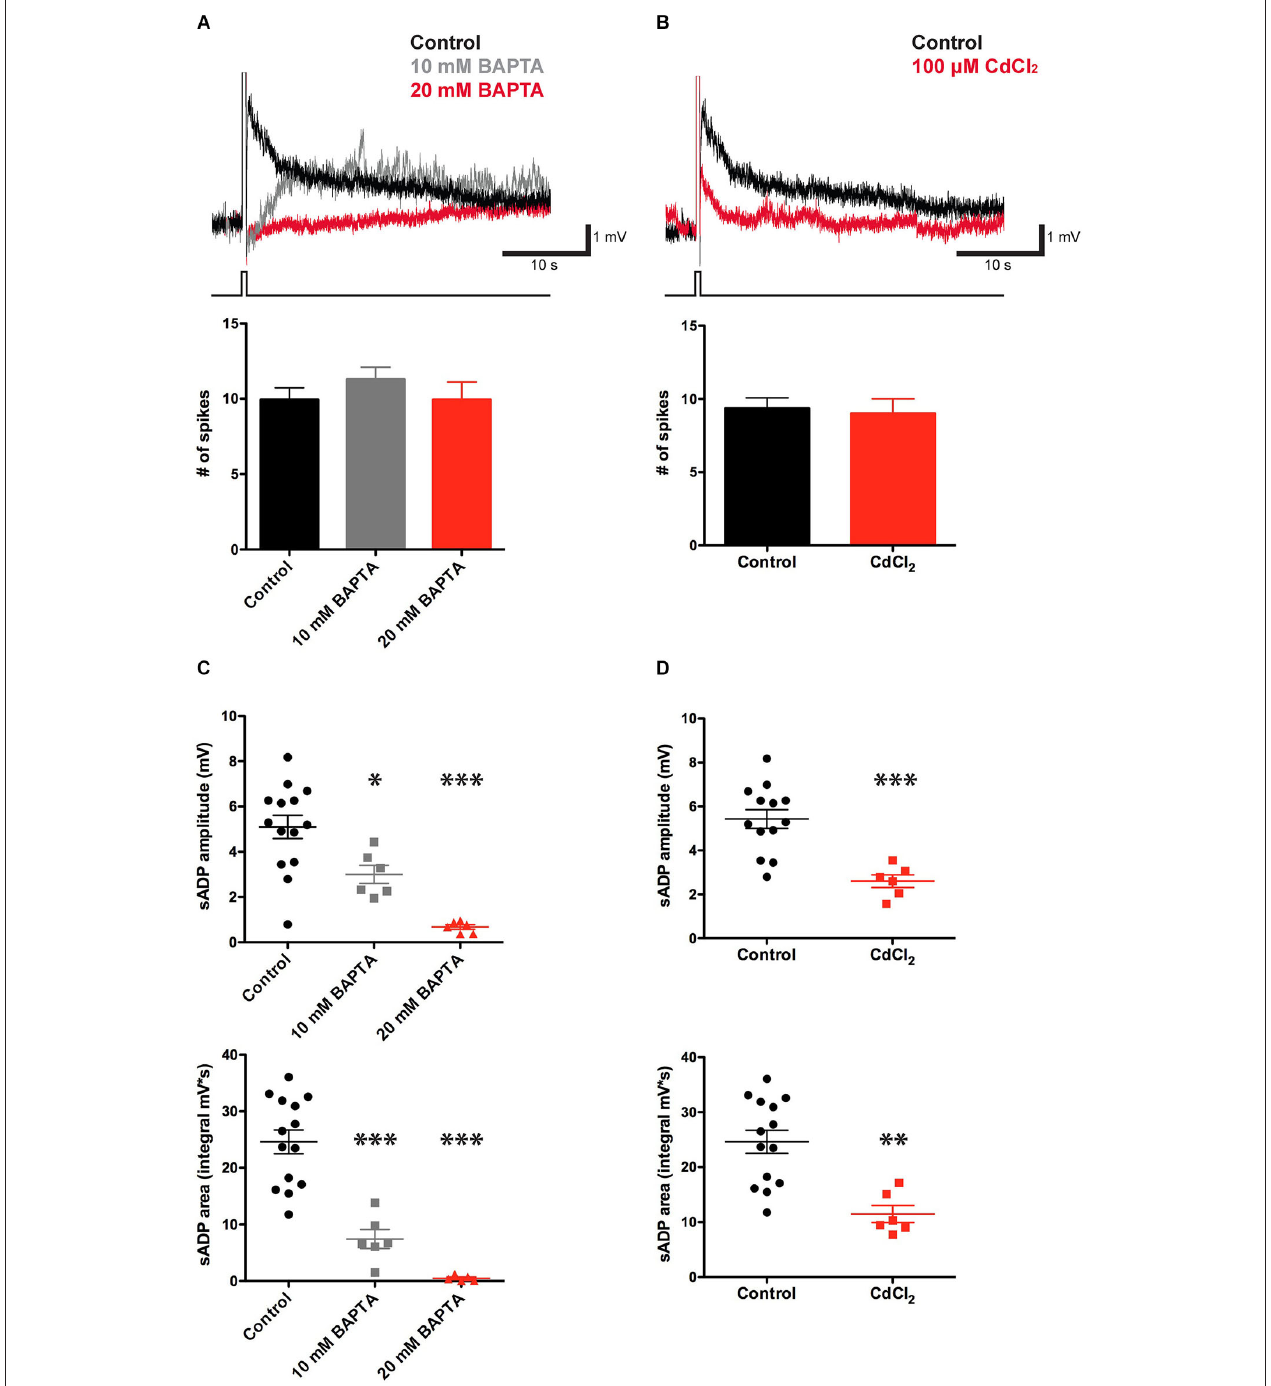
application of Cd 2 + reduced the sADP. Inset: sADPs induced by a depolarizing current step (in CCh) under control conditions (black trace) or in the presence of 100 µ M Cd 2 + (red trace). Bar graph, number of spikes during the depolarization was not affected by Cd 2 + ( n = 6–16, P = 0.77). (C) BAPTA significantly reduced peak amplitude ( n = 6–14, * P < 0.05, *** P < 0.0001) and area ( n = 6–14, *** P < 0.0001) of sADP triggered by a 200 pA depolarizing current step for 500 ms. (D) Cd 2 + decreased sADP amplitude ( n = 6–13, *** P < 0.001) and area ( n = 6–14, ** P <